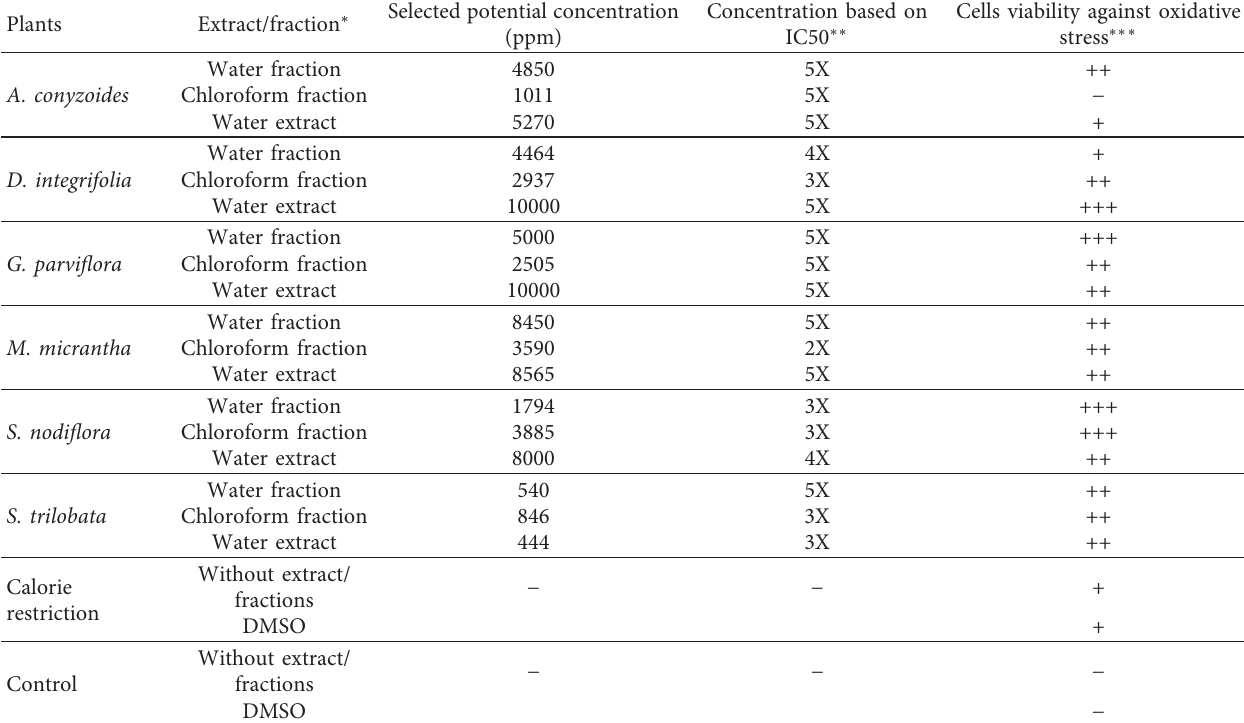
Table 3: Effect of selected concentration of plant extract/fraction on yeast cells viability.